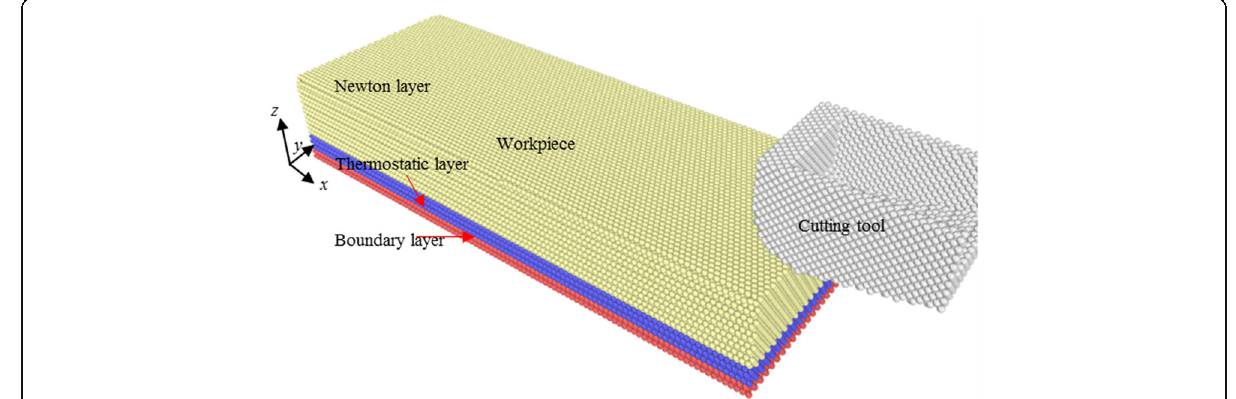
Fig. 1 Simulation model for diamond-cutting